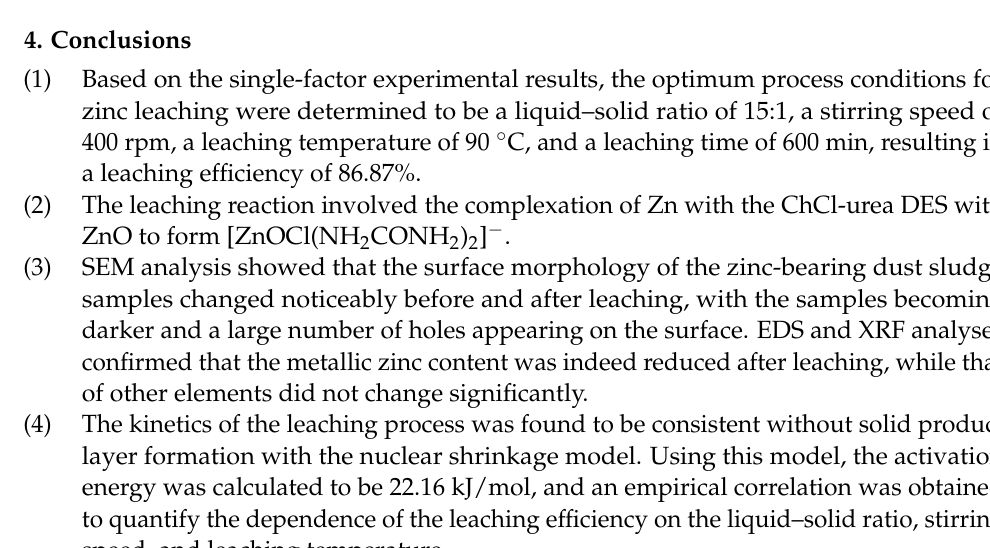
Figure 12. Change curve of lnk with different factors:( a ) liquid–solid ratio; ( b ) Stirring